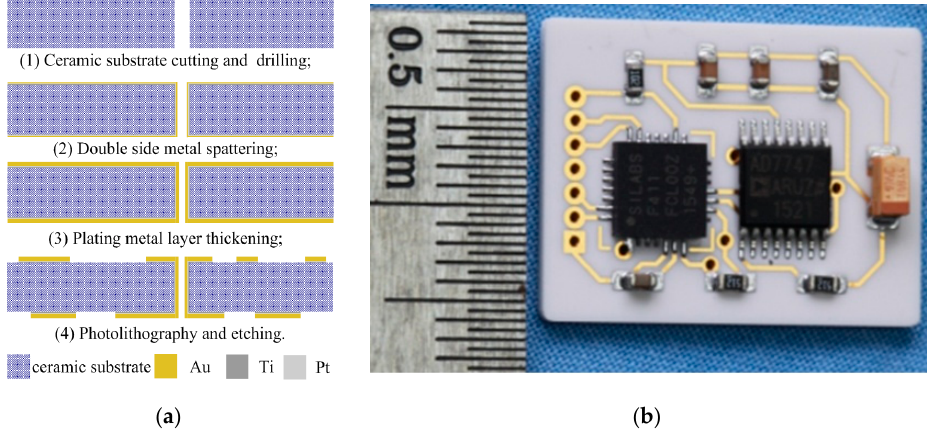
Figure 5. Technological process and photo for the ceramic-based interface circuit. ( a ) Technological process; ( b ) Photo.